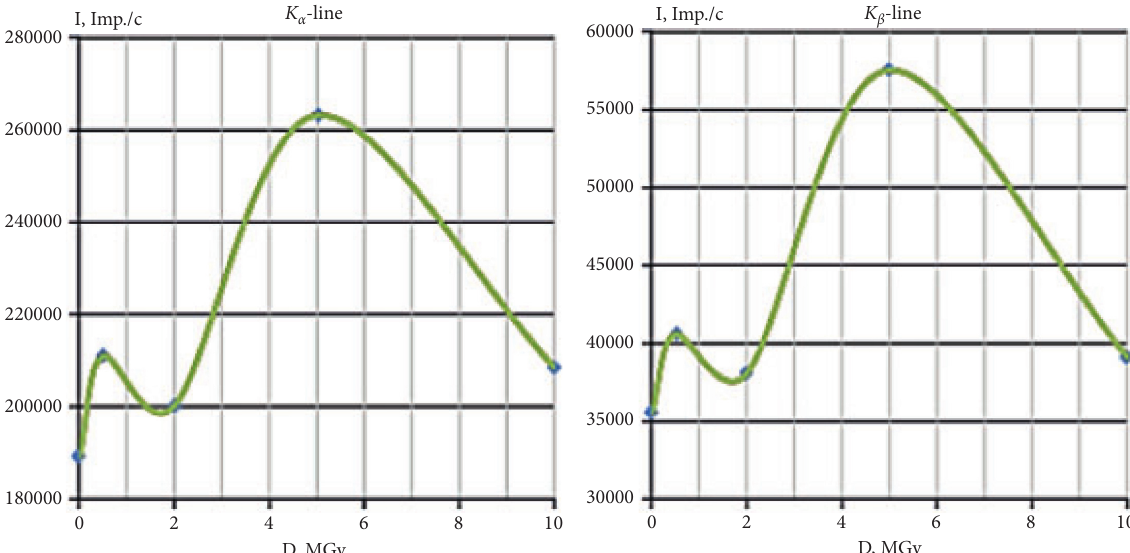
Figure 17: Changes in the fluorescence intensity of the K α and K β lines of the titanium atom, in a composite based on modified titanium hydride under the action of c